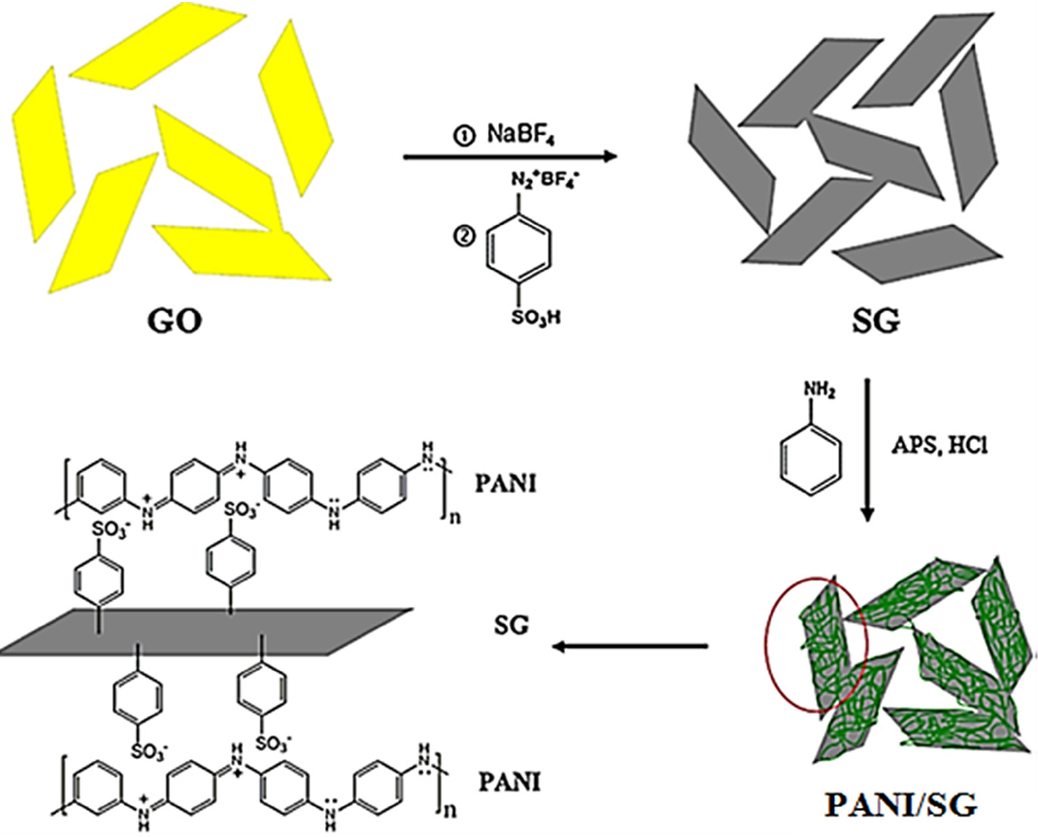
Figure 3. Schematic of SG, PANI/SG nanocomposite, and multilayer film assembled based on multiple interactions between positively charged PANI and negatively charged SG [70]. SG = sulfonated graphene.